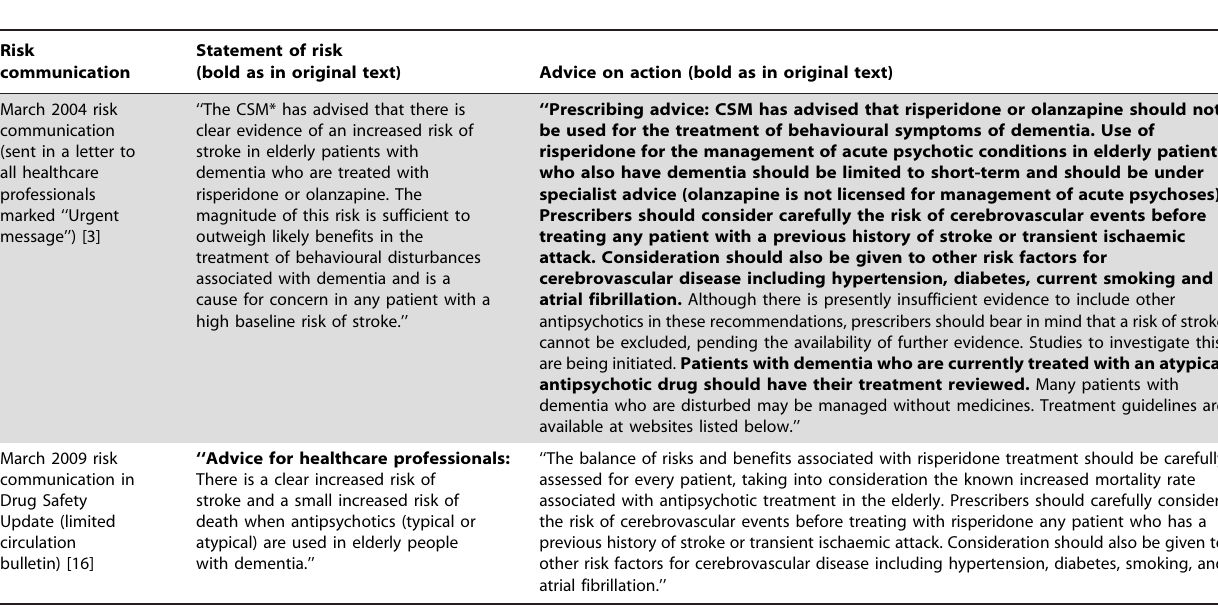
Table 1. 2004 and 2009 risk communications concerning antipsychotic use in older people with dementia.